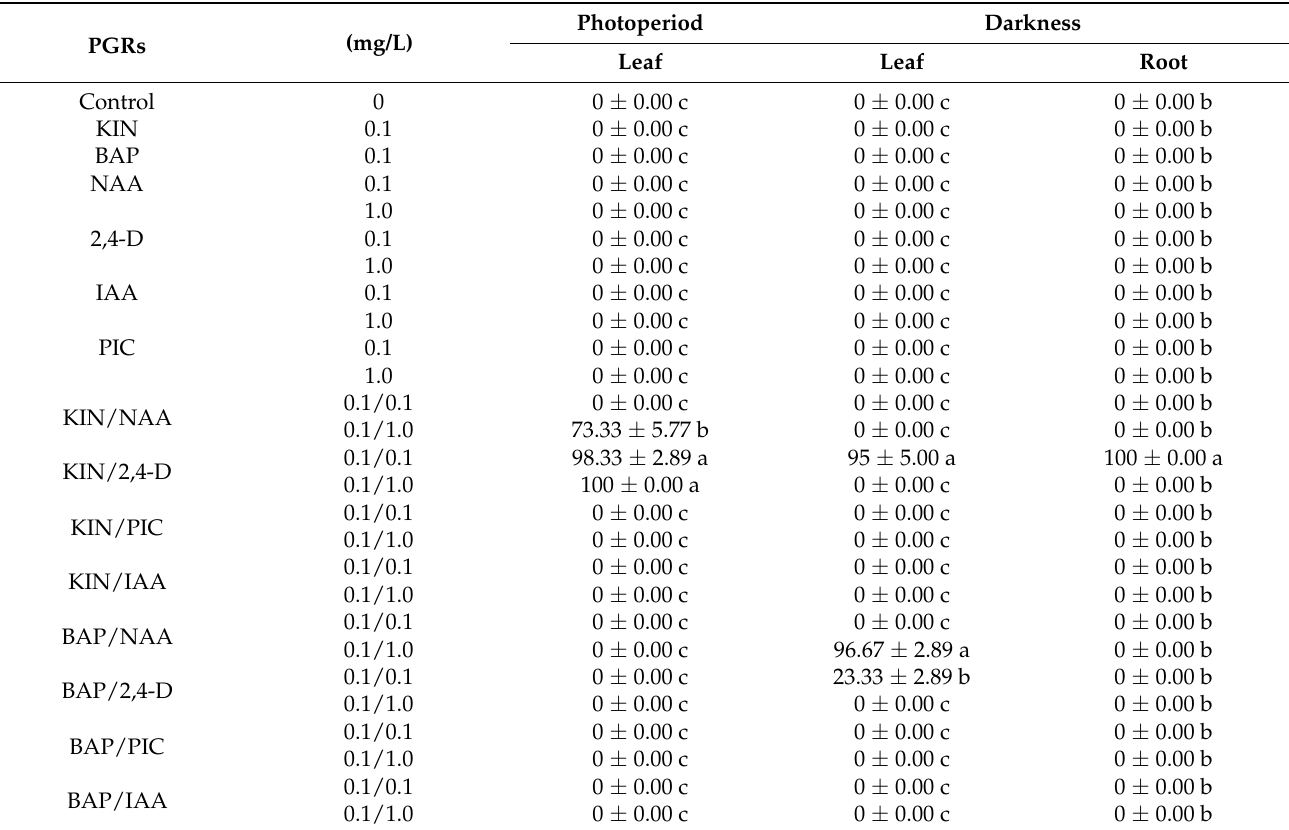
Table 2. Effect of plant growth regulators on callus–root induction of A. ludoviciana through different types of explants in two incubation conditions.